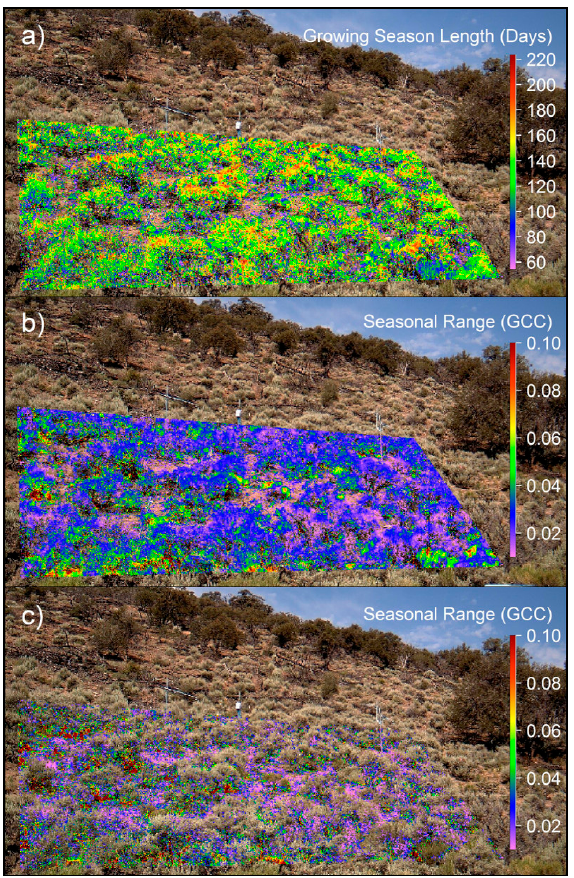
Figure 9. ( a ) Growing season length (GSL) illustrated for pixels of vegetation, data are from the gray bars in Figure 8c; ( b ) Seasonal GCC range of vegetation, pixels of vegetation were determined from the gray bars in Figure 8c; ( c ) Seasonal GCC range of the interspace, interspace pixels were determined from red bars in Figure 8c. Interspace pixels were as follows: green to red match bark and shadows and violet to blue match bare ground. ( b , c ) scales were kept fixed from 0.01–0.1 to highlight the two distributions.